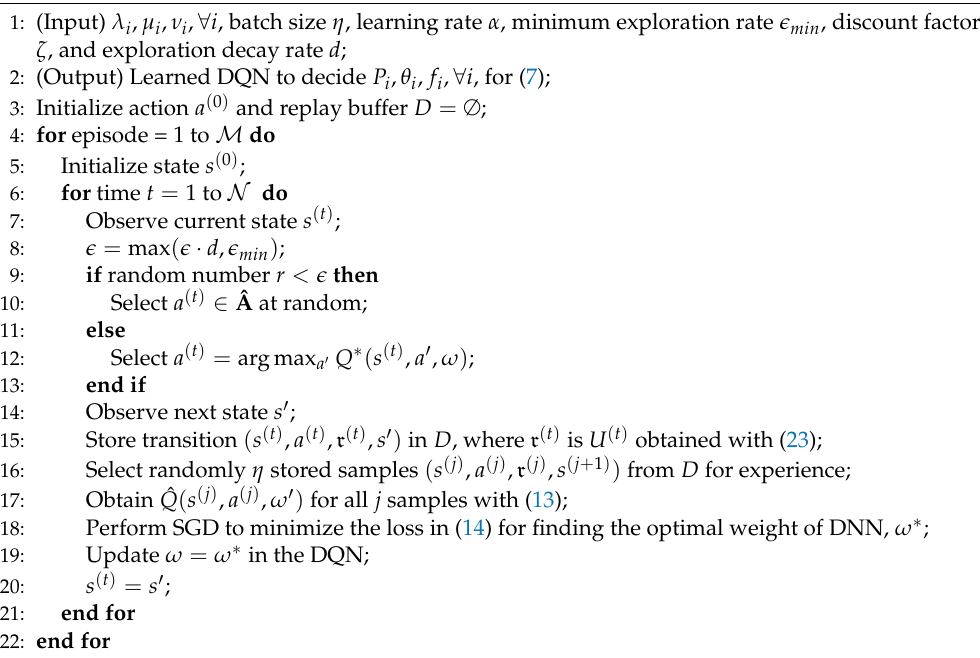
Algorithm 1 The single-layer DQN-based MRA training